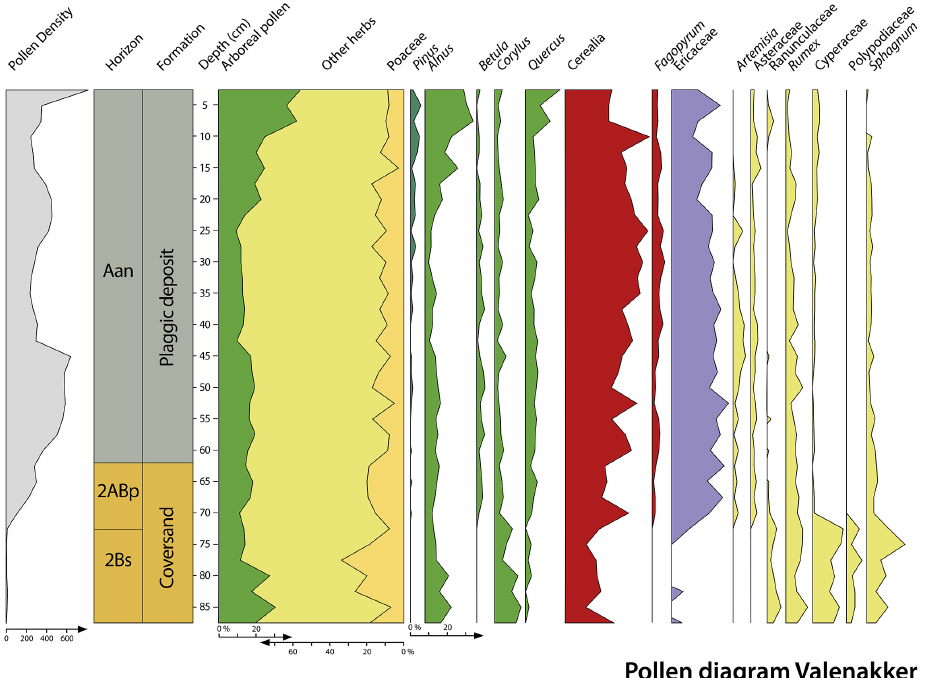
Figure 8. Pollen diagram Valenakker. Pollen density in kgrainmL − 1 .